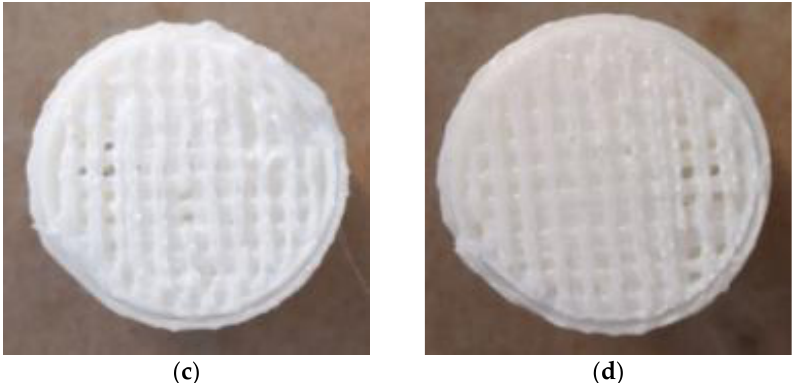
Figure 12. Images of the bottoms of the experimental grid-support parts removed under different grid support densities: ( a ) 30% grid support density (bottom view); ( b ) 50% grid support density (bottom view); ( c ) 70% grid support density (bottom view); ( d ) 90% grid support density (bottom view).